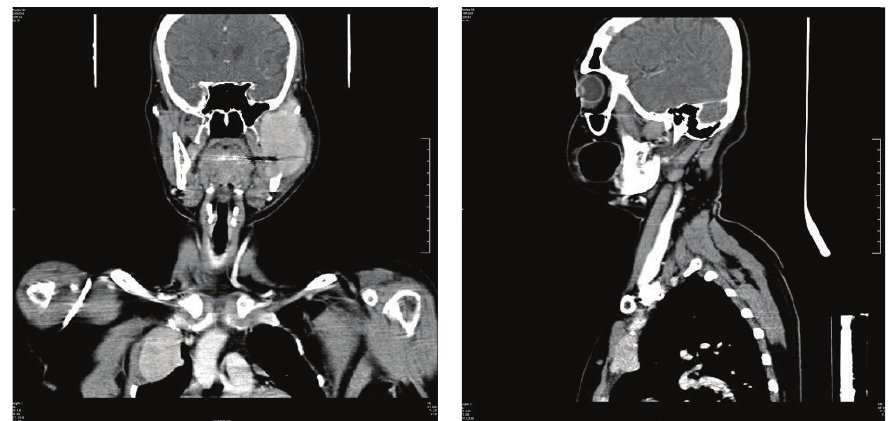
Figure 5: Coronal and sagittal sections of CT demonstrating the extent of the lesion.